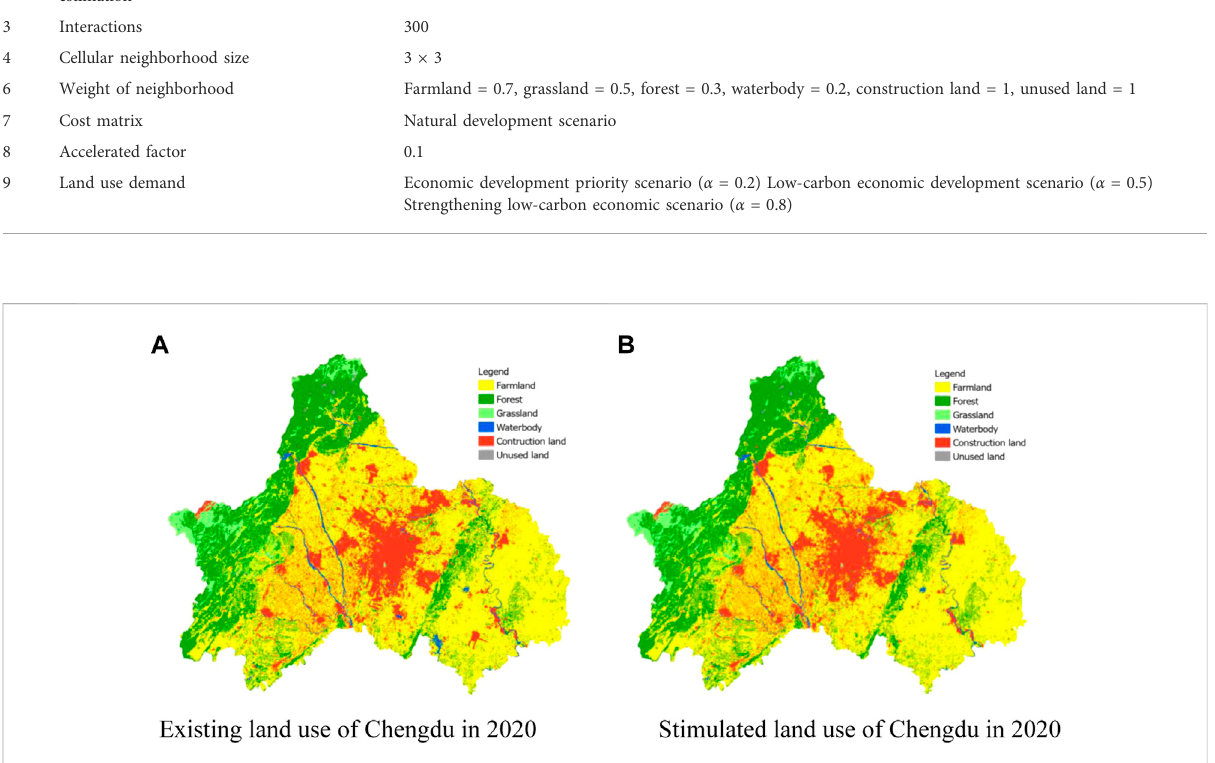
FIGURE 8 Actual land use map and simulated land use map of Chengdu in 2020.